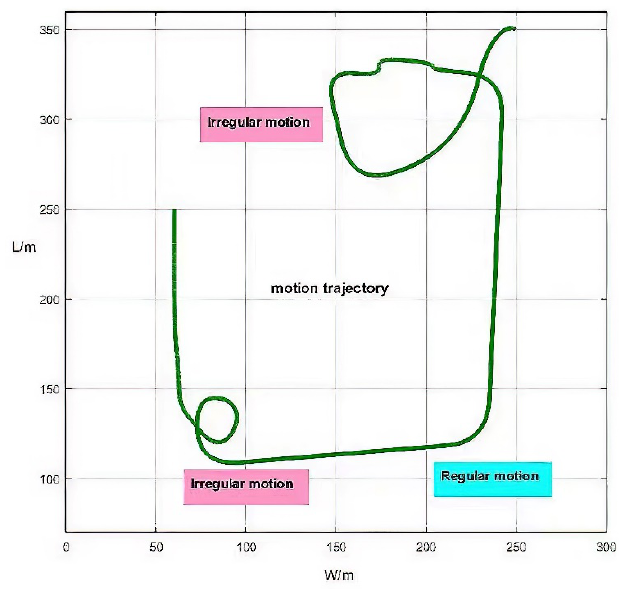
Figure 2. Motion trajectory diagram.